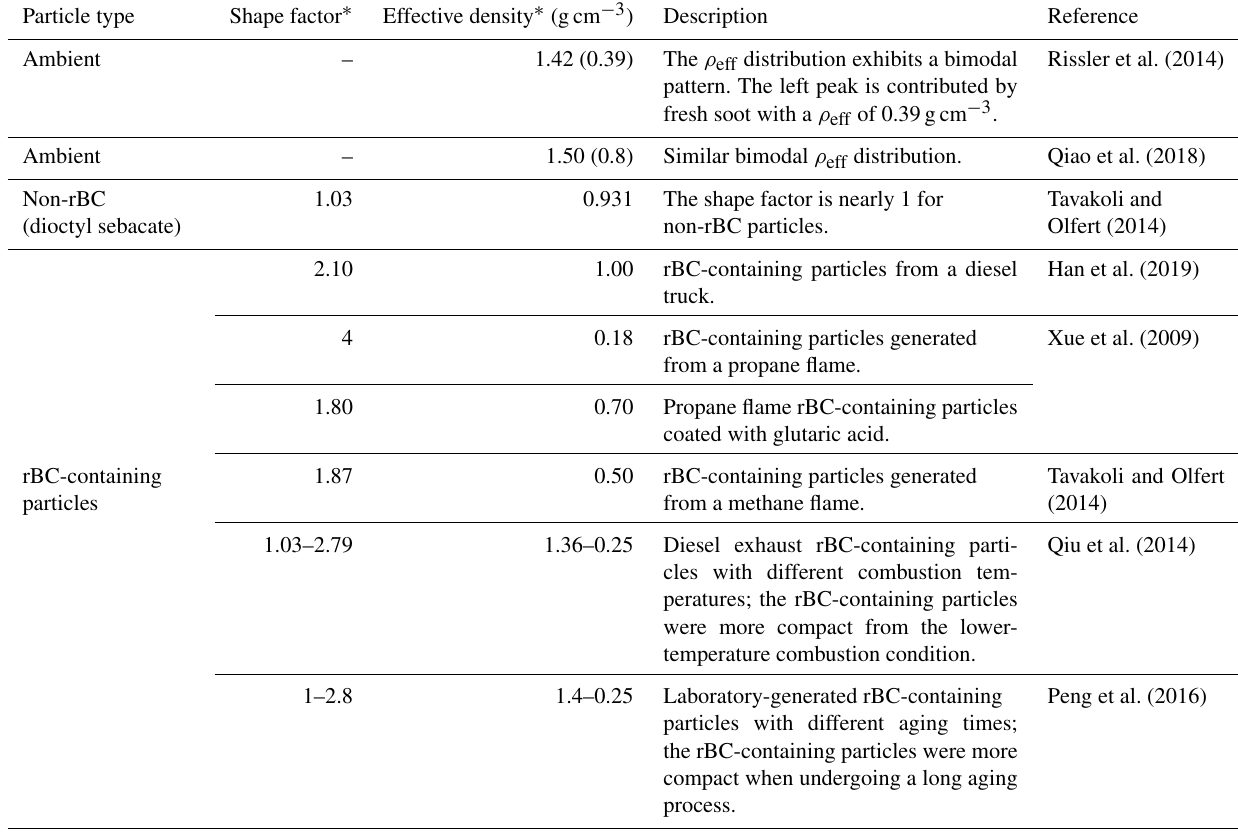
Table 2. Brief summary of the effective density and dynamic shape factor of rBC-containing